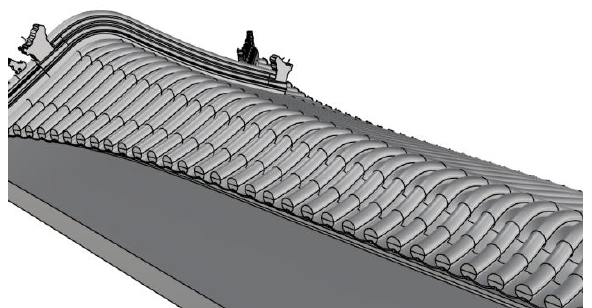
Figure 17. Round-ridge roof ( juanpeng ) with a gutter